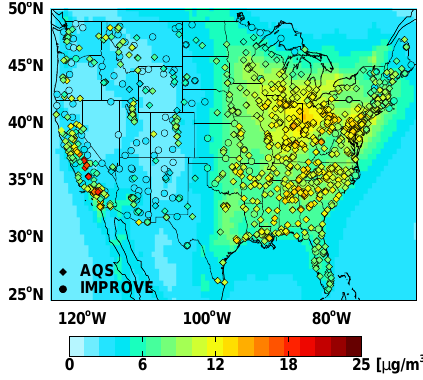
Figure 4. GEOS-Chem simulated average surface PM 2 . 5 mass for years 2004–2011 overlaid with measurements at IMPROVE (cir- cles) and AQS sites